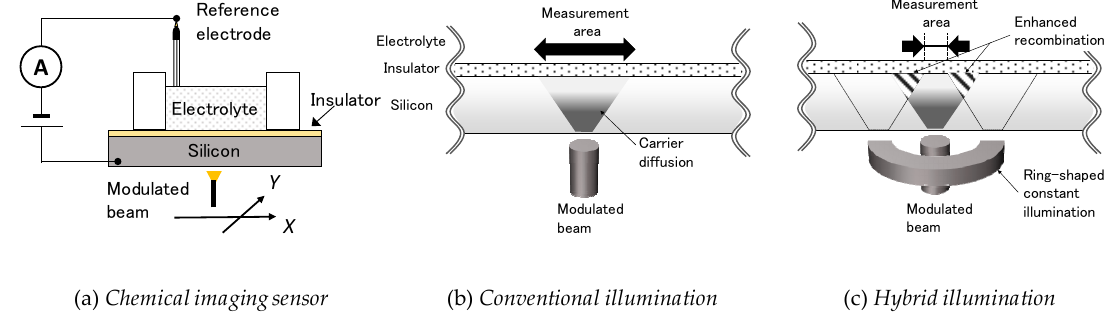
Figure 1. ( a ) Schematic view of chemical imaging sensor scanned by a modulated light beam. Carrier diffusion in cases of ( b ) conventional illumination and ( c ) hybrid illumination proposed in this study, respectively.